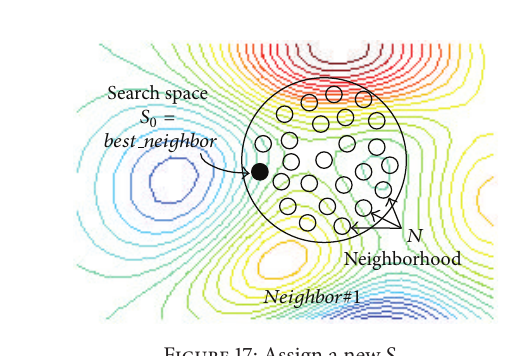
Figure 17: Assign a new 𝑆 0 .